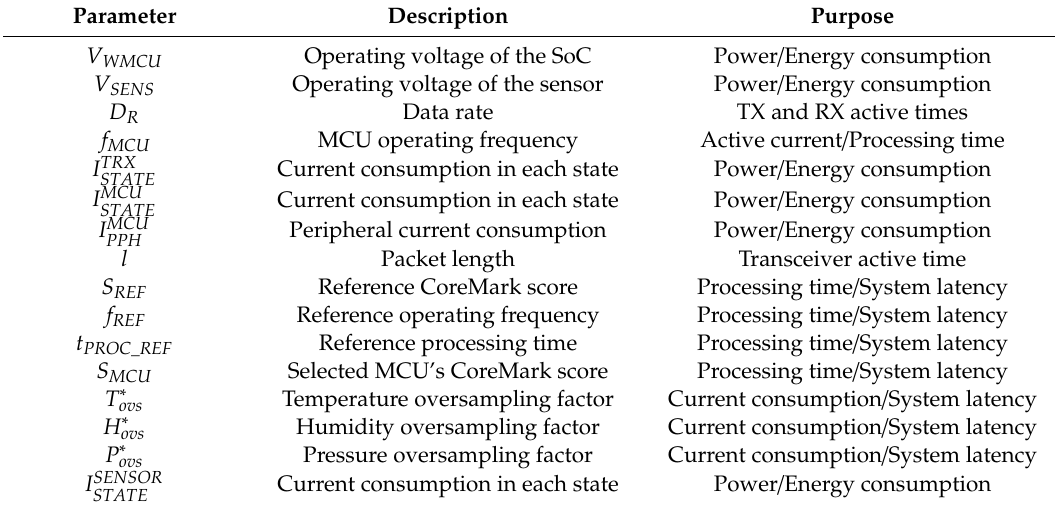
Table 1. Energy model